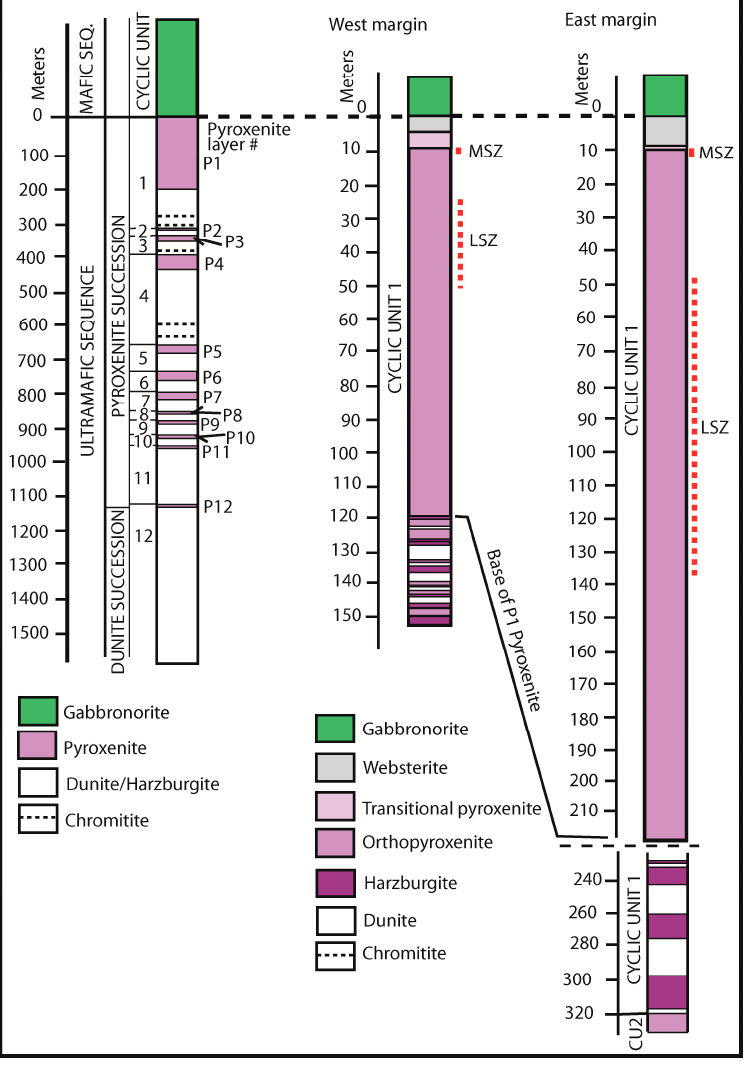
Figure 3. Diagram showing lithostratigraphic sections for the Shurugwi Subchamber (After Wilson et al., 2000) [30]. The complete section, derived from both field and borehole core data, is based on distribution of rock types in the axial region whereas the West and East margins are based on borehole core data from the western and eastern parts of the axial region